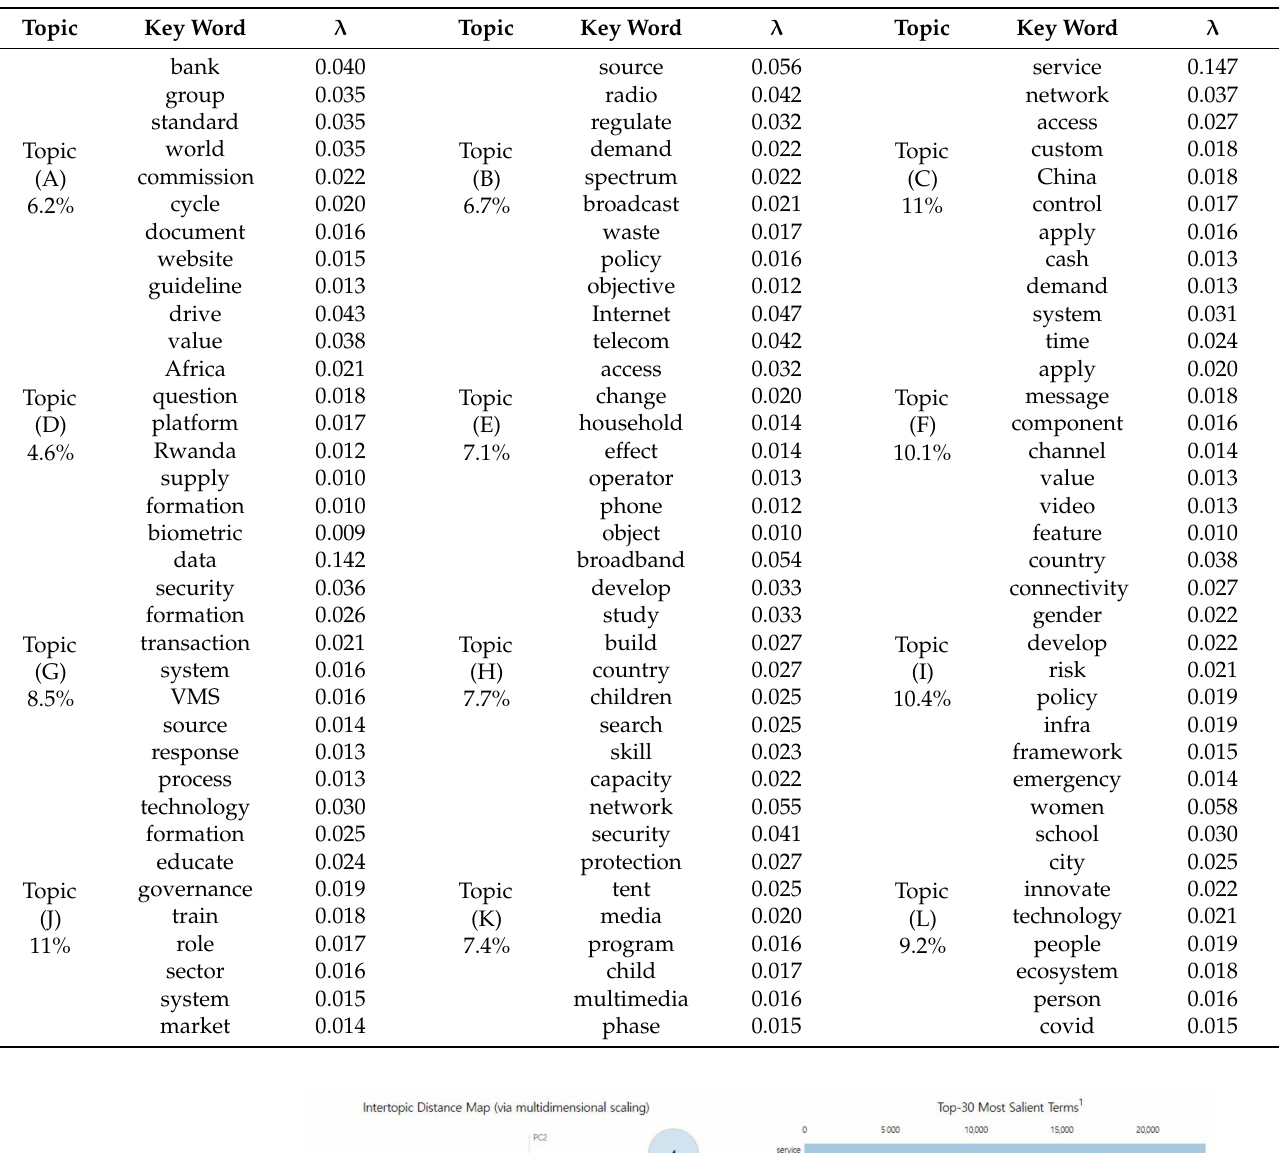
Table 3. Topic modeling analysis result.